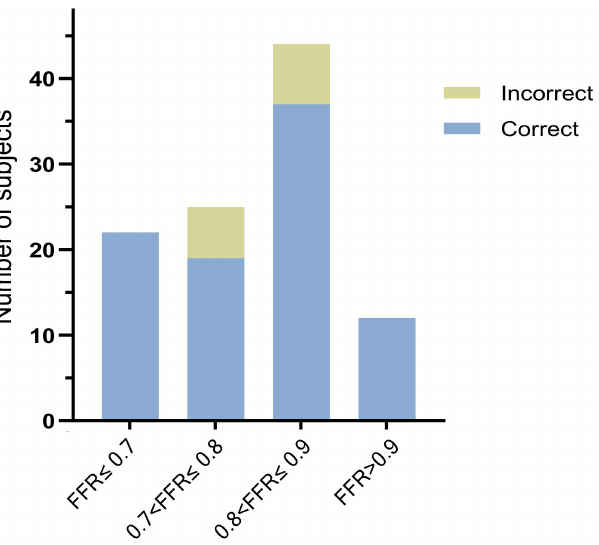
Figure 7. The diagnostic accuracy of CTP-FFR in correctly identifying the hemodynamically signifi- cant lesions among the different invasive FFR groups. All abbreviations same as in Table